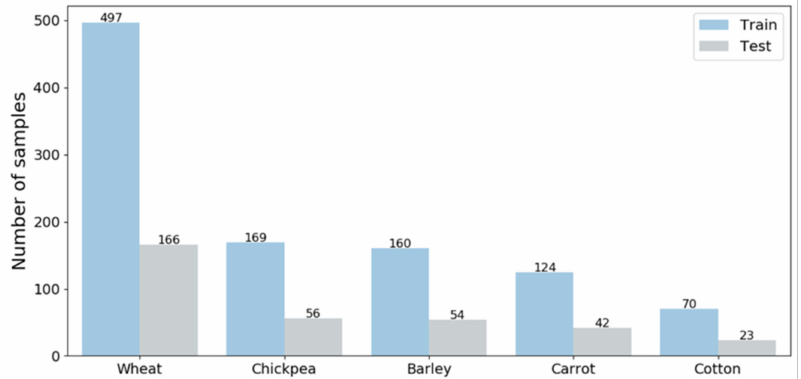
Figure 4. Train and test dataset distribution for each